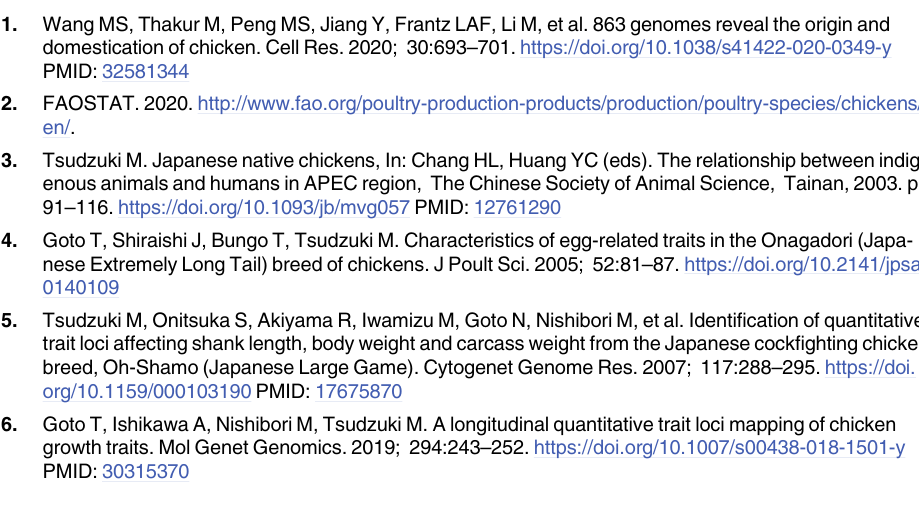
expressed by ellipses. Blue and red ellipses indicate positive and negative correlations in each pair (P < 0.05). Blank cells show no significance. S1 Table. Degree of freedom, F value, and P value of one-way